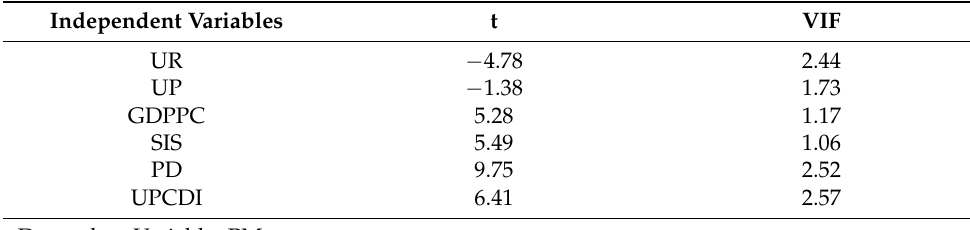
Table A1. Multicollinearity Test.